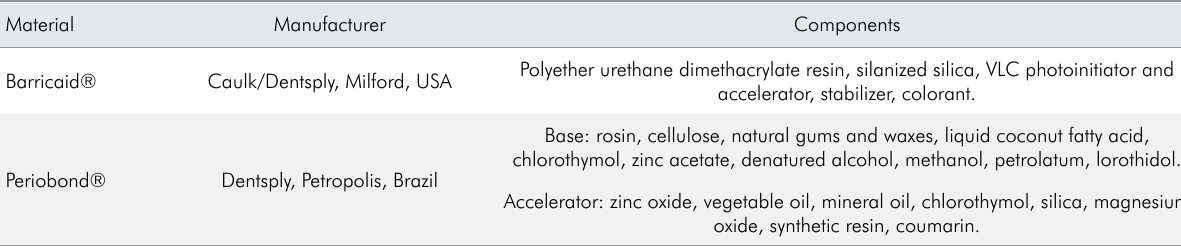
Table 3. Materials used as commercial reference and their components.